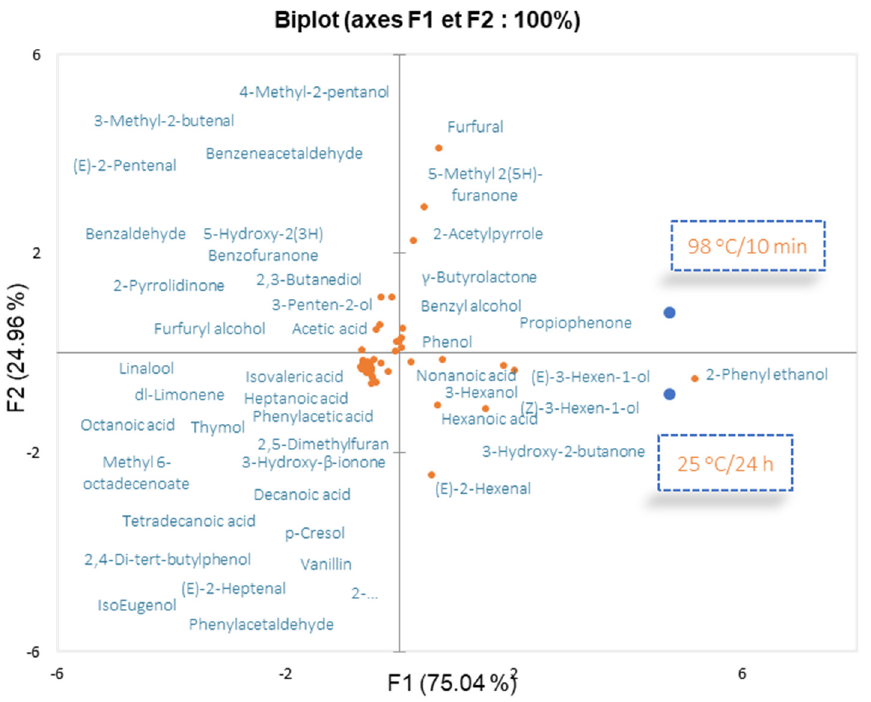
Figure 1. PCA biplot of aroma compounds in Moringa herbal tea.